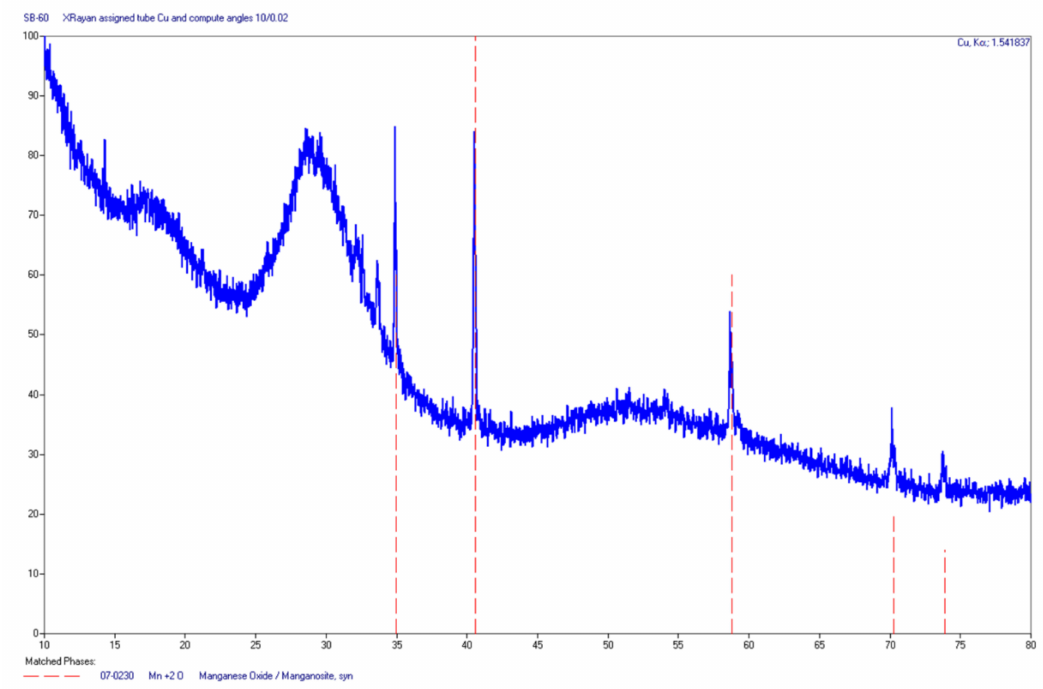
Figure 11. Diffractogram of the residue of the composition containing 60 wt%